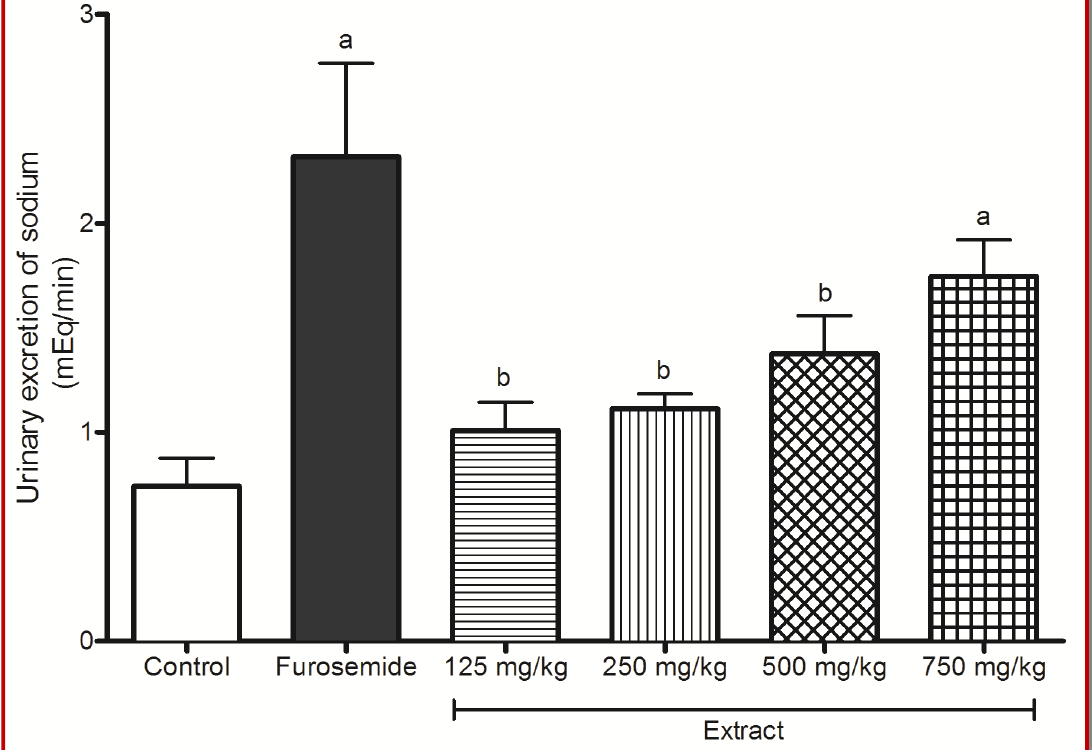
Figure 2: Effect of aqueous extract of E. polystachya on urinary excretion of sodium in rats. Mean ± SEM of six animals per group; a p<0.05 compared with control group; b p<0.05 compared with furosemide